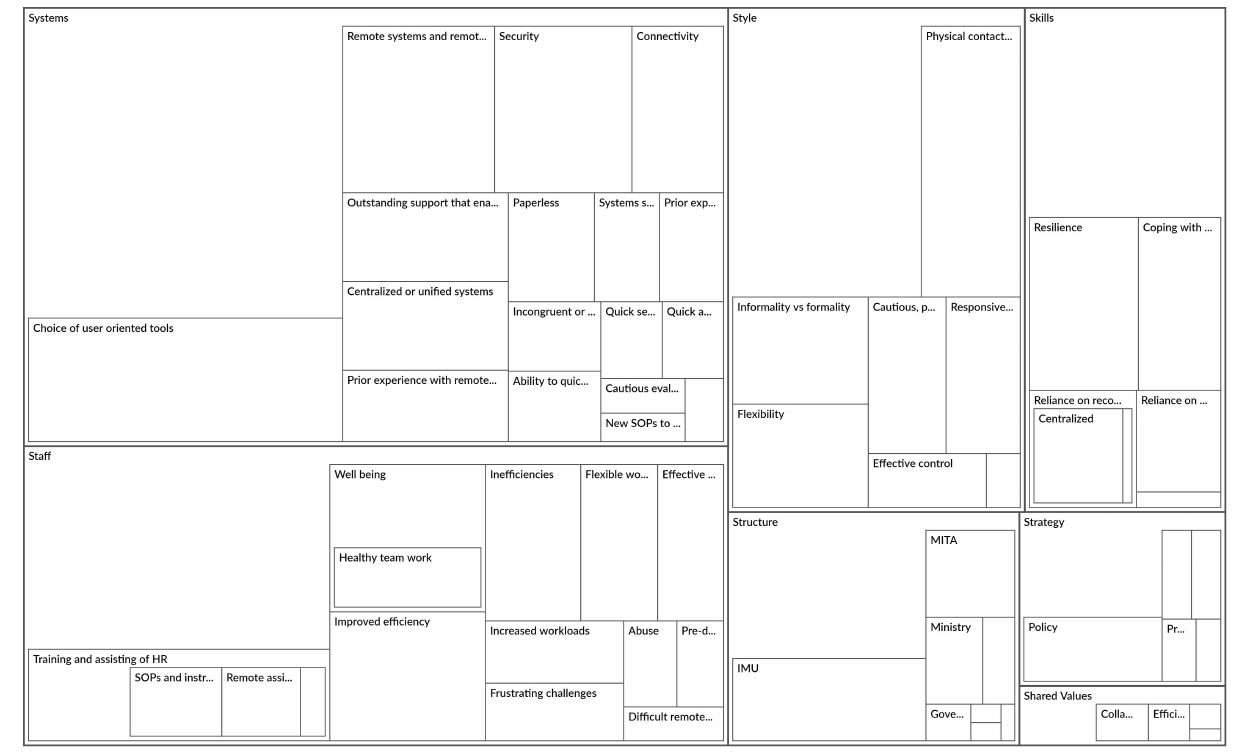
FIGURE 1 | Graphic summary of the key themes emerging from the study, with coding consistent with 7S framework (Source: